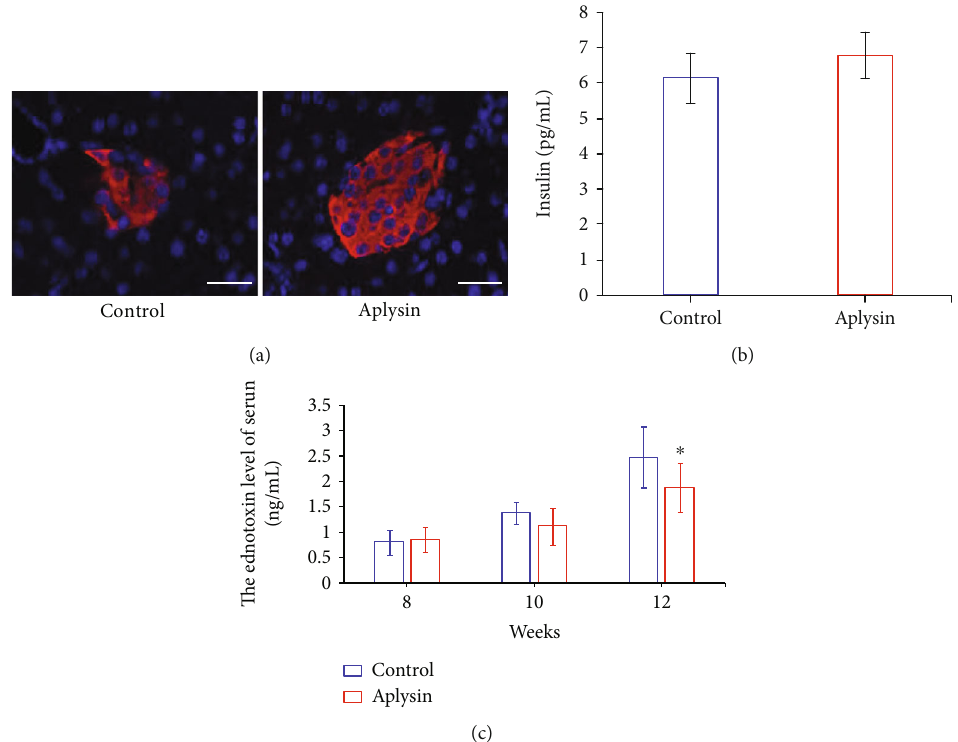
Figure 3: Levels of insulin in the pancreas and the serum and endotoxin in the serum. (a) Immuno fl uorescence staining of insulin in the pancreas. Scale bar = 40 μ m . Red: insulin distribution; blue: cell nuclei stained with DAPI. (b) Insulin levels in serum of mice assessed by ELISA. (c) Endotoxin in serum of mice assessed by ELISA. ∗ p < 0 : 05 vs. the